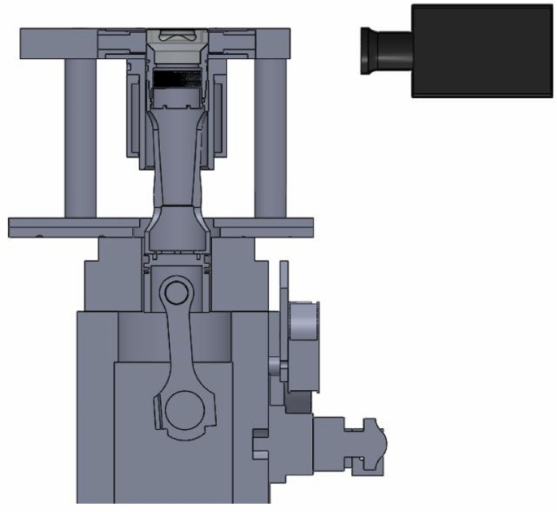
Figure 3. Side view of the camera and engine